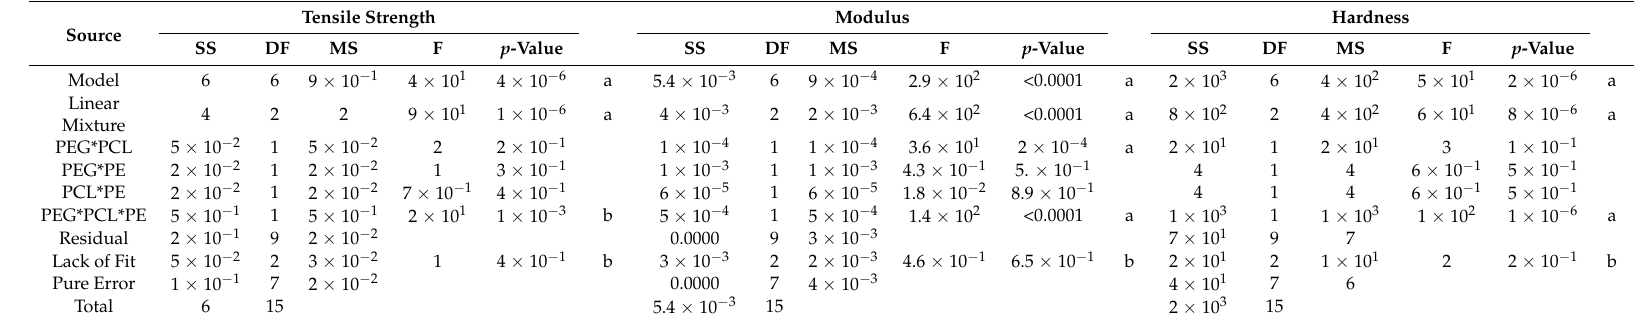
Table 4. ANOVA of model regression of tensile strength, modulus and